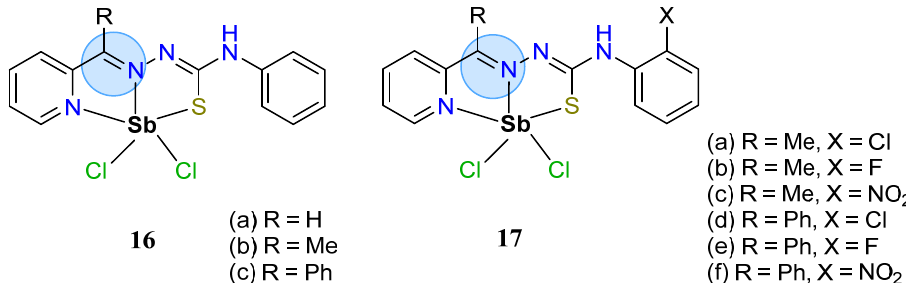
Figure 9. Antimony(III) complexes with N(4) ‐ phenyl ‐ 2 ‐ pyridine ‐ derived thiosemicarbazones lig ‐ ands studied in antimicrobial activity.